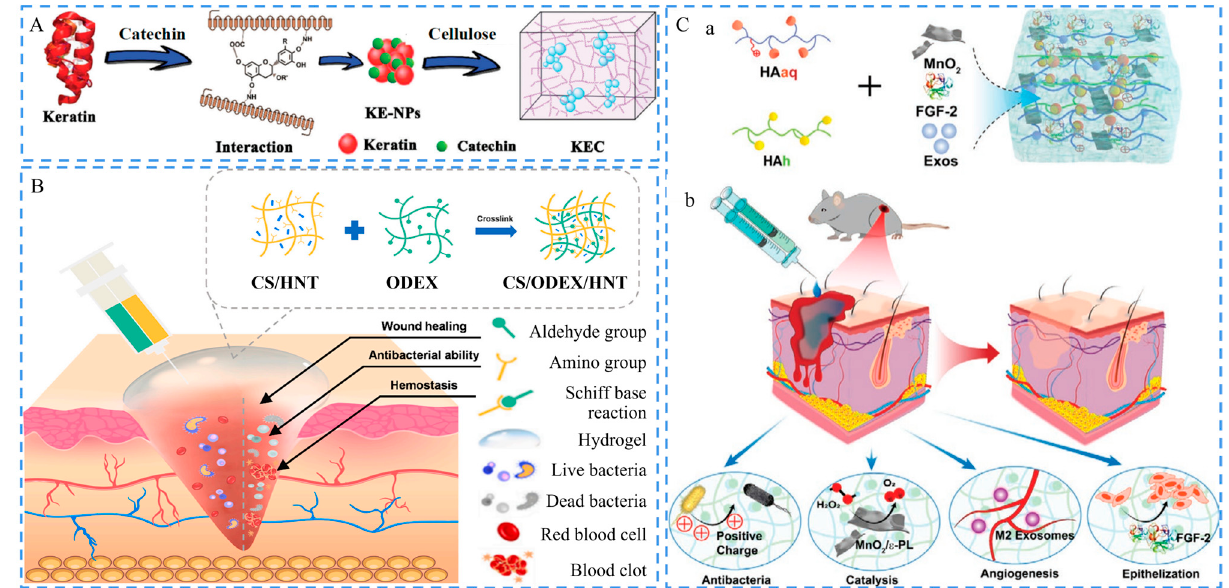
Figure 4. Schematics of hemostatic hydrogels. ( A ) Schematic of molecular assembly of keratin-catechin (KE)-NPs and formation of the cellulose/keratin-catechin composite hydrogel (KEC). Reproduced with permission [54]. Copyright 2018, Royal Society of Chemistry. ( B ) Schematic of the CS/ODEX/HNT hydrogel. The hydrogel was prepared in situ by the crosslinking between CS and ODEX via the Schiff base reaction and showed homeostatic and antibacterial abilities. Reproduced with permission [55]. Copyright 2021, Elsevier. ( C ) Preparation and application of the HA@MnO 2 /FGF-2/Exos hydrogel. (a) The preparation procedure for the hydrogel. (b) The hydrogel could promote wound healing by killing bacteria, catalyzing H 2 O 2 decomposition, and accelerating neovascularization and re-epithelialization. Adapted with permission [63]. Copyright 2021, Wiley-VCH.